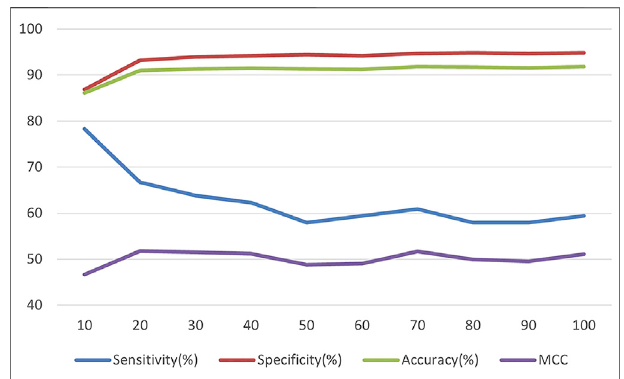
FIGURE 4 | The relationship between learning rate and model